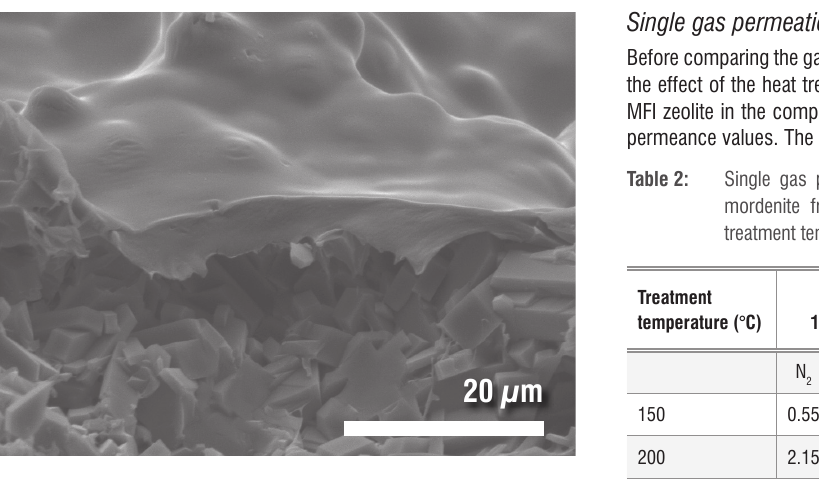
Figure 9: Scanning electron micrograph of the cross-section of the composite ceramic membrane after temperature treatment at 150 °C.